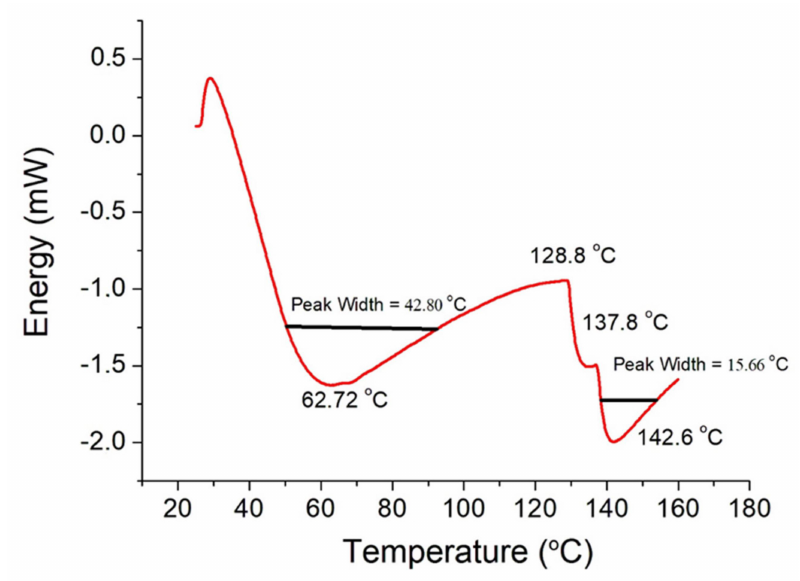
Figure 7. DSC thermogram of a sample.